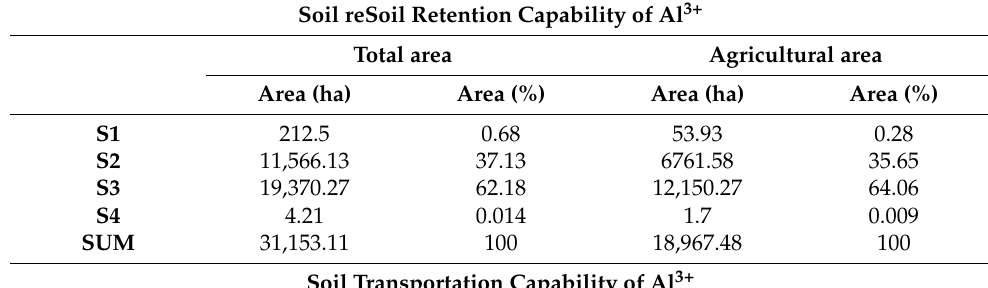
Table 5. Total area for each level of soil retention and transportation capability in Trang